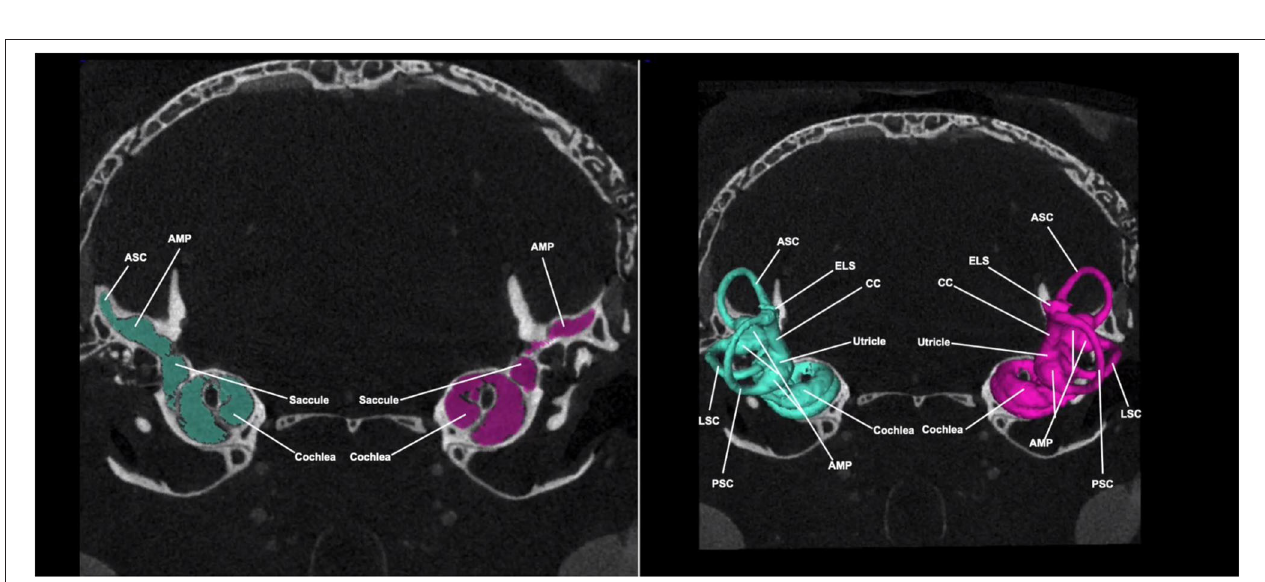
FIGURE 4 | Micro-CT image with 3D segmentation of the adult inner ear. Shown here is a Micro-CT image of the adult mouse head in the coronal view. The 3D segmentation is seen overlayed on the 2D image (right). The color seen in the 2D image corresponds with its respective 3D segmentation. At this stage, inner ear structures have completed maturation and reached their final configuration. ASC, anterior semi-circular canal; LSC, lateral semi-circular canal; PSC, posterior semi-circular canal; CC, common crus; ELS, endolymphatic sac; AMP, ampulla.